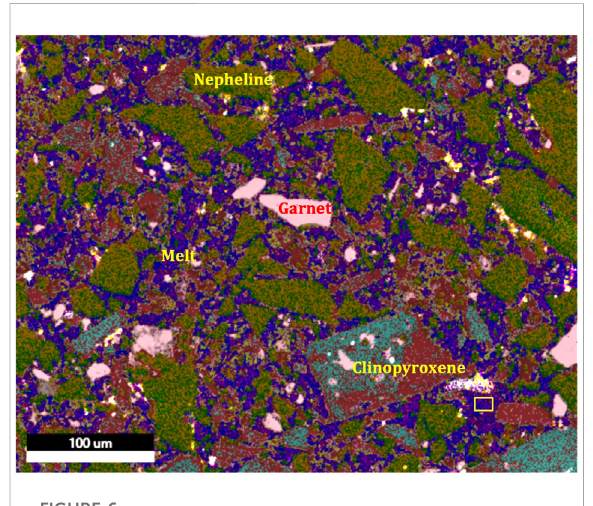
FIGURE 6 X-ray phase map of lower portion of ODL-5wk. Silicate minerals maintain their broken starting material appearance and are surrounded by quenched “ melt ” (deep blue in color) which basedon EDSpeaksconsistsofC-Na-Si-S-K-Ca-O (seetext; yellow rectangle denotes location of analysis). Primary silicate minerals are nepheline (green), Ti-andradite garnet (pink), and clinopyroxene (turquoise and maroon). The grain labeled clinopyroxene shows how remnant high Mg CPX is replaced by NaFe clinopyroxene.